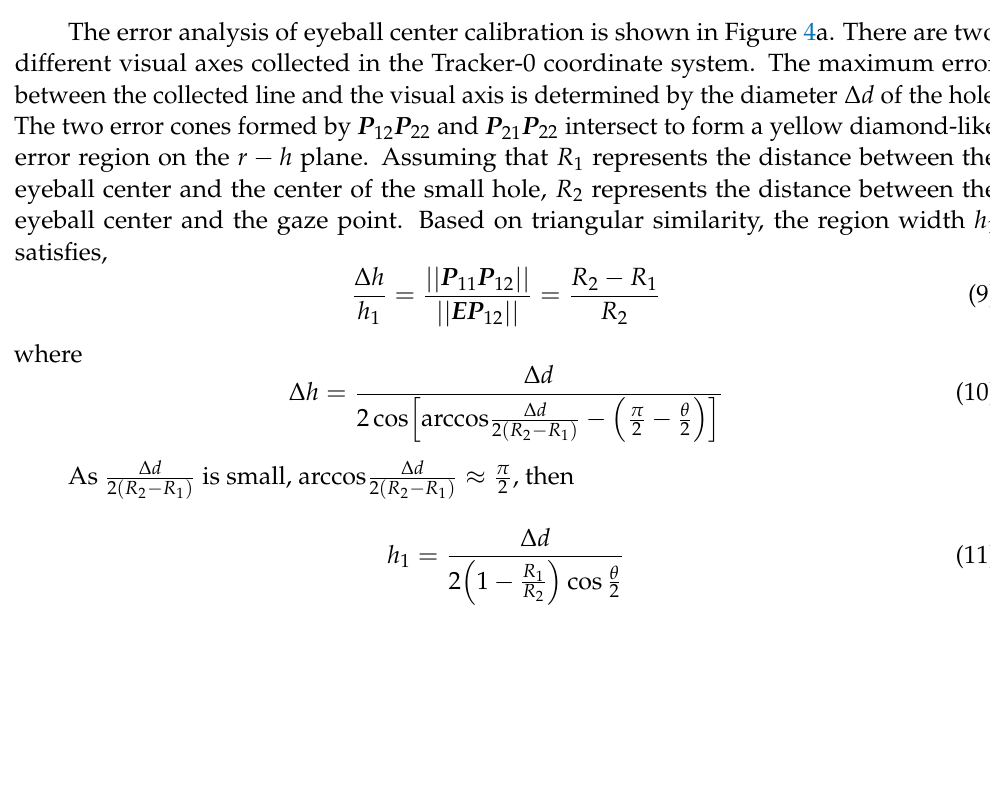
Figure 3. Estimation of the eyeball center E with developed calibration tools. The transformation between Tracker-2 and the small hole is predefined, and the coordinate of gaze point in Tracker-3 coordinate system is